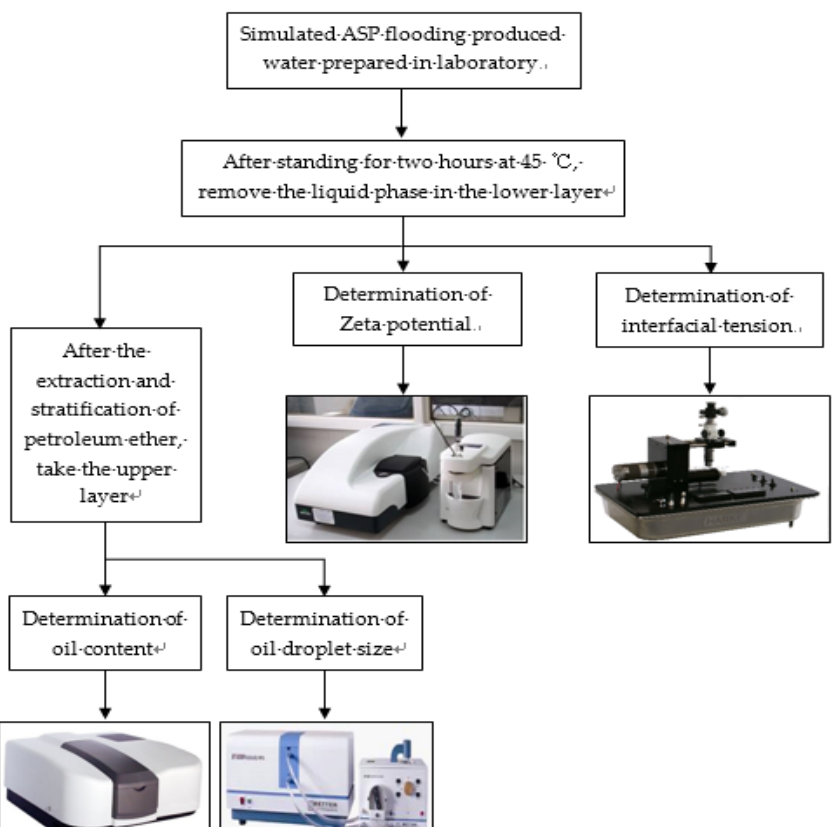
Figure 1. The experimental set-up in the laboratory.